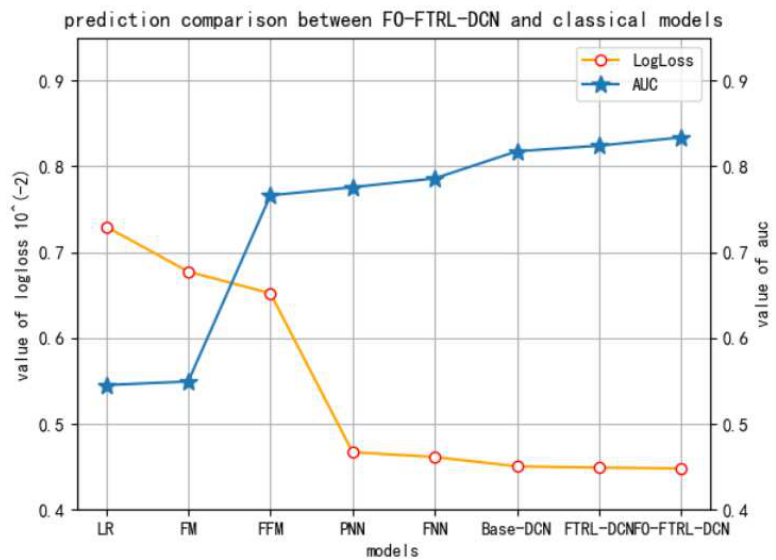
Figure 8. The comparison between FO-FTRL-DCN and classical